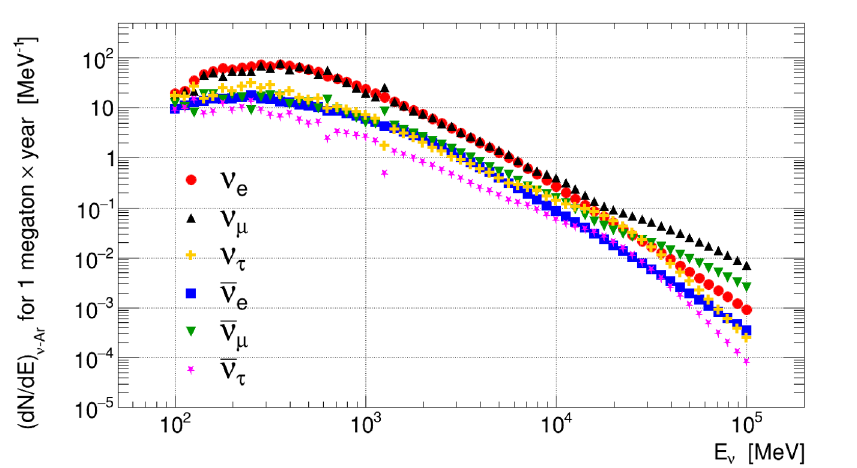
Figure 2 . Differential atmospheric neutrino energy spectra for neutrino-argon interactions nor- malized to 1 megaton · year , resulting from the oscillated HKKM2014 flux tables and GENIE cross sections in the reference sample. The corresponding spectra in the alternative sample show only small deviations at the level of 1 %